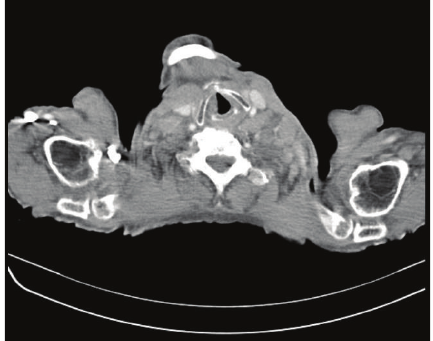
Figure 5: Cervical CT demonstrating multiple enlarged lymph nodes in the paratracheal, subcarinal, bilateral supraclavicular, and cervical regions. Figure 6: Abdominal CT demonstrating multiple enlarged lymph